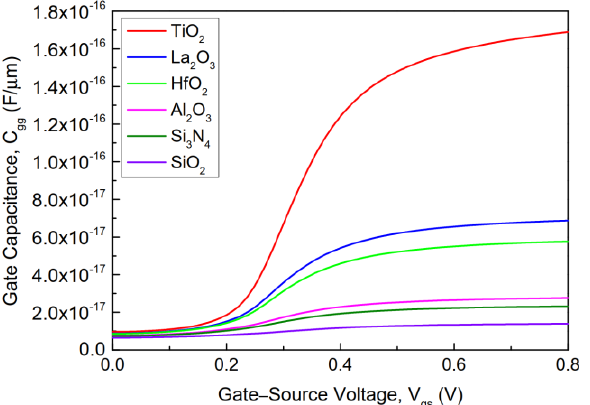
Figure 12. Gate capacitance as a function of gate–source voltage with different gate dielectric materials at V ds = 0.05 V.